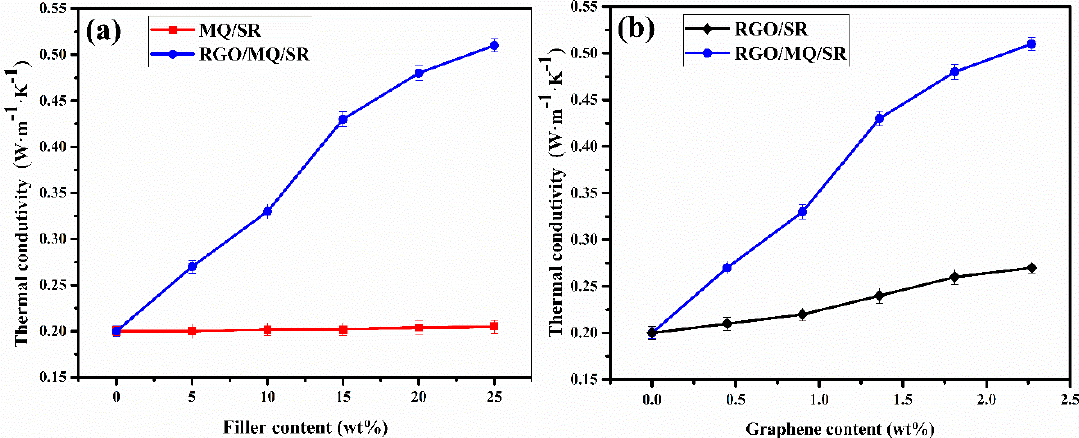
Figure 6. ( a ) Thermal conductivity of MQ/SR composites and RGO/MQ/SR composites with different filler contents; ( b ) thermal conductivity of RGO/MQ/SR composites and RGO/SR composites with different graphene contents.